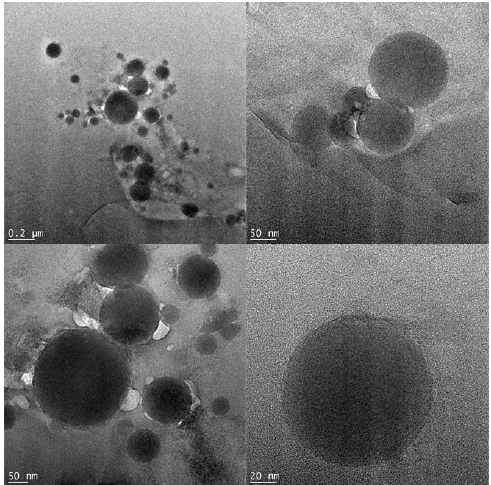
Figure 6. TEM images of nanospheres of coordination polymer 1 (sonochemical synthesis).